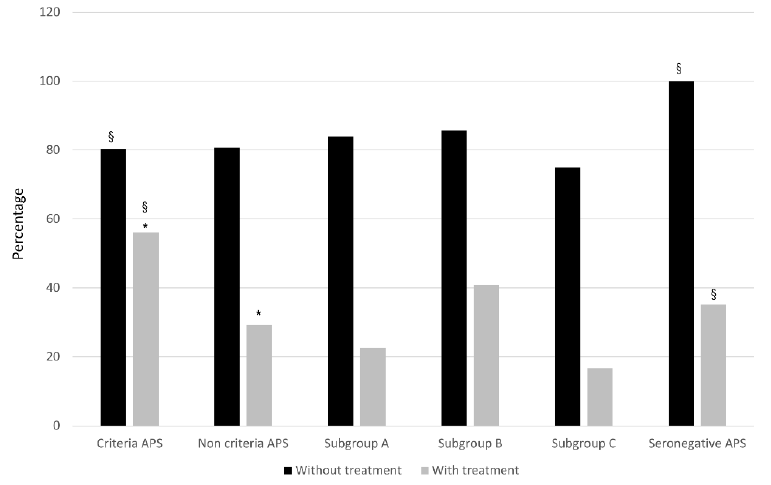
Figure 2. Adverse Pregnancy Outcomes (APO) in the different groups according to treatment. Rates of patients with APO are expressed as percentages in the different groups according to standard (SoC) treatment. Adverse pregnancy outcome (APO) includes early pregnancy loss, fetal death, preeclampsia, abruptio placentae, and preterm birth (< 37 weeks). * Criteria APS vs. NC ‐ APS: p < 0.0001; § Criteria APS vs. SN ‐ APS: p < 0.05.